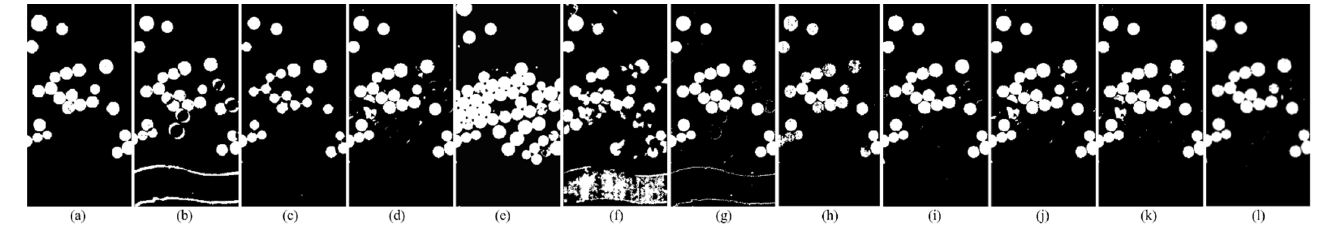
Figure 9. Binary detection results in the Hermiston dataset: ( a ) ground truth, ( b ) LSCD, ( c ) ASCD, ( d ) HOSVD, ( e ) TDRD, ( f ) PCANet, ( g ) DSFANet, ( h ) HI-DRL, ( i ) SSTN, ( j ) UTT-SVD, ( k ) UTT-noSVD, and ( l ) STT.